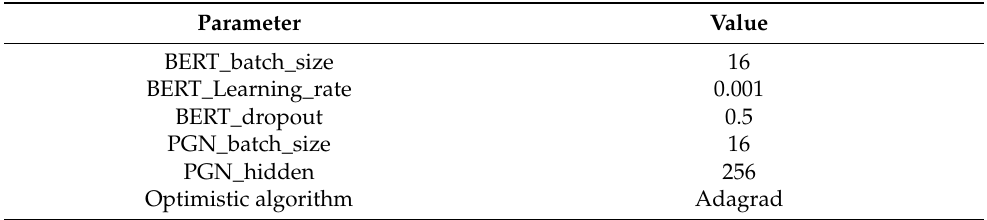
Table 3. Hyper parameter settings for answer generation